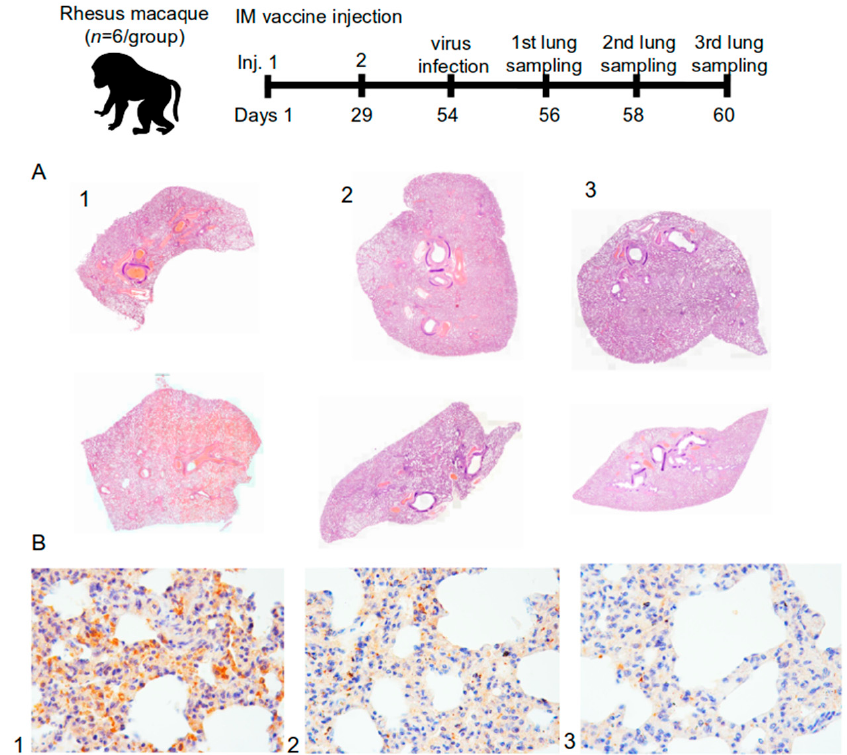
Figure 7. ( A ) Histotopogram of macaque representative lung samples taken on the 6th day after the infection of rhesus macaques with the SARS-CoV-2; ( B ) IHC-reaction to S-protein (brown reaction product) in representative lung tissues of rhesus macaque (1—control, 2—5 µ g dose, 3—20 µ g dose); stained with hematoxylin; magnification 250 × ( n = 72).